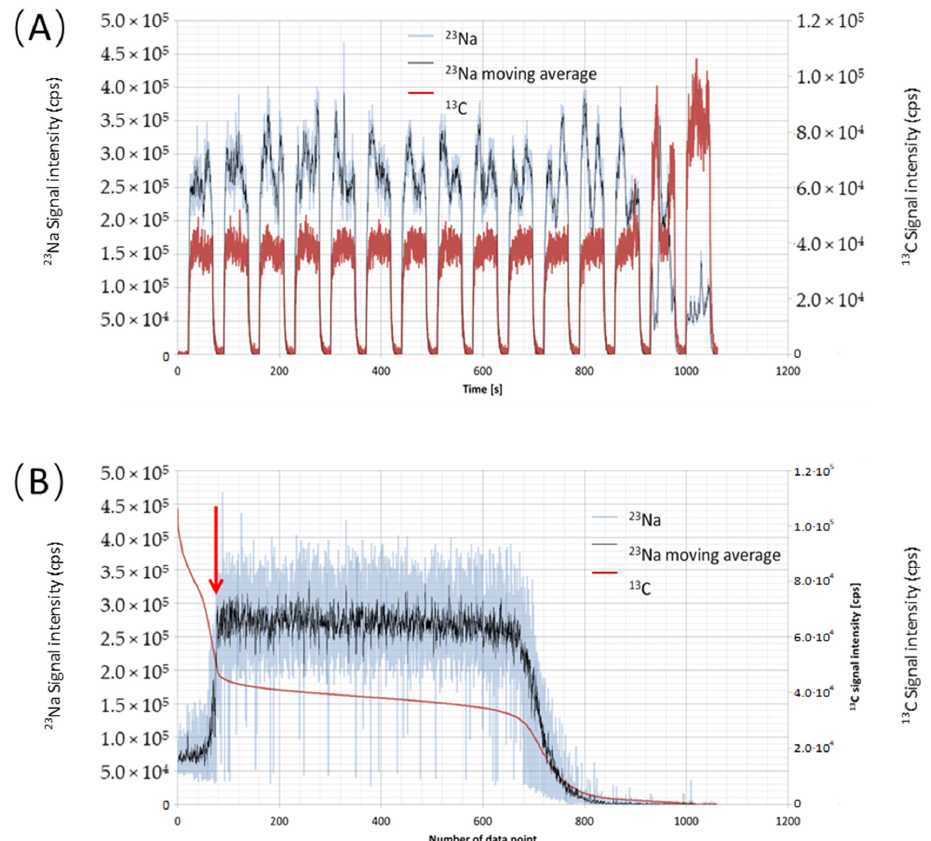
Figure 2. Signal intensity versus number of data points plotted before ( A ) and after ( B ) sorting by descending signal for isotope 13 C. The cut-off point between two ROIs is marked with a red arrow. Exemplary plots are presented for the same sample as in the last column in Figure 1. All registered data (Figure 2A) were ordered as C descending (Figure 2B). A signal integration range was selected to omit the problem with variable heterogeneity of the samples and to extract the areas of the condensed chemical information from each ROI separately [71]. Signal intensities (normalized to 13 C as IS) from each ROI of each sample were averaged separately. Through principal component analysis, it was shown that even after excluding C from calculations, the difference between F-ROI and W-ROI was clearly visible (Figure 3). Moreover, two groups of coexisting elements can be distinguished: (1) Na, K and Cl (with similar tendency for Fe and Al); and (2) Ca, Cu, Mg, P, S, and Zn.